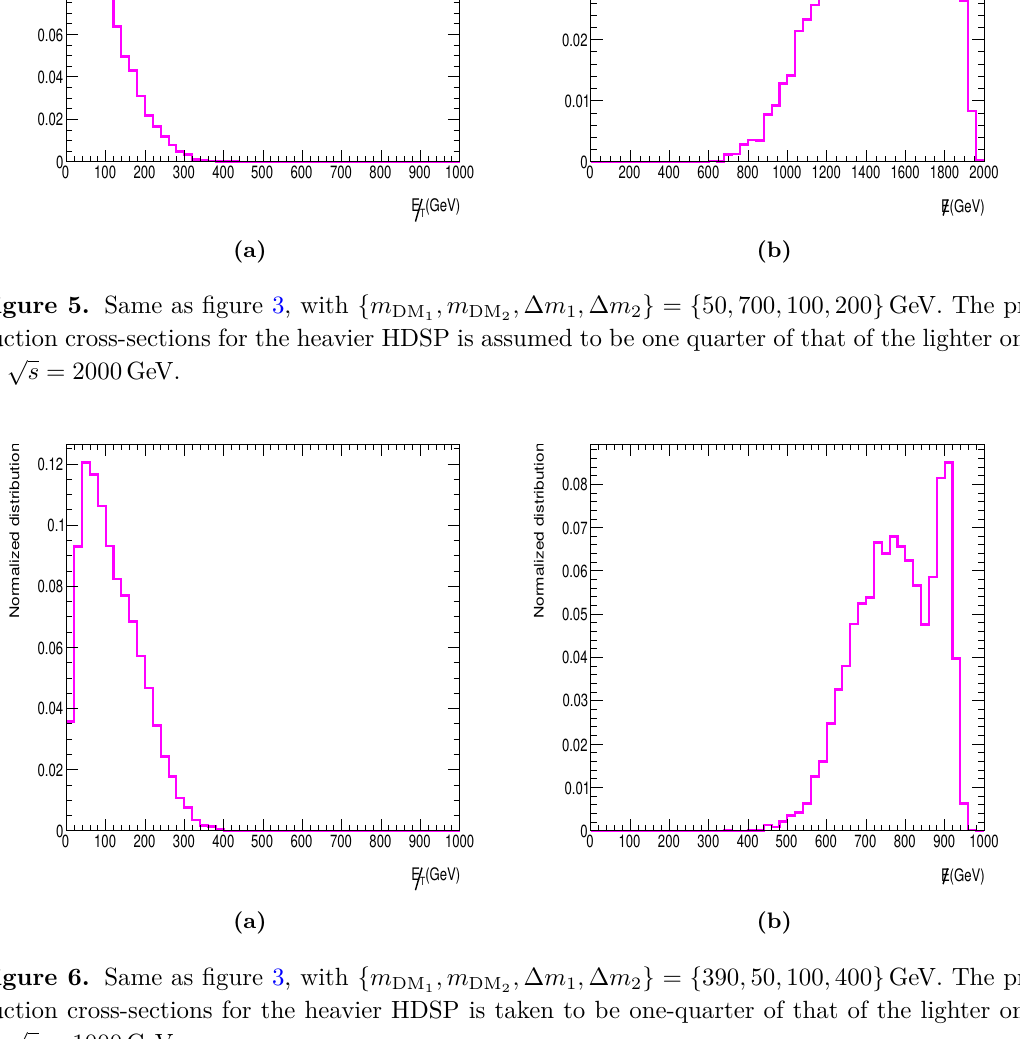
, m DM , ∆ m 1 , ∆ m 2 } = { 390 , 50 , 100 , 400 } GeV. The pro- 1 2